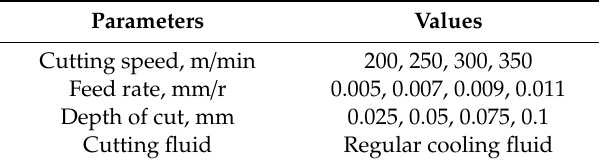
Table 1. Cutting parameters of average cutting force measurement.